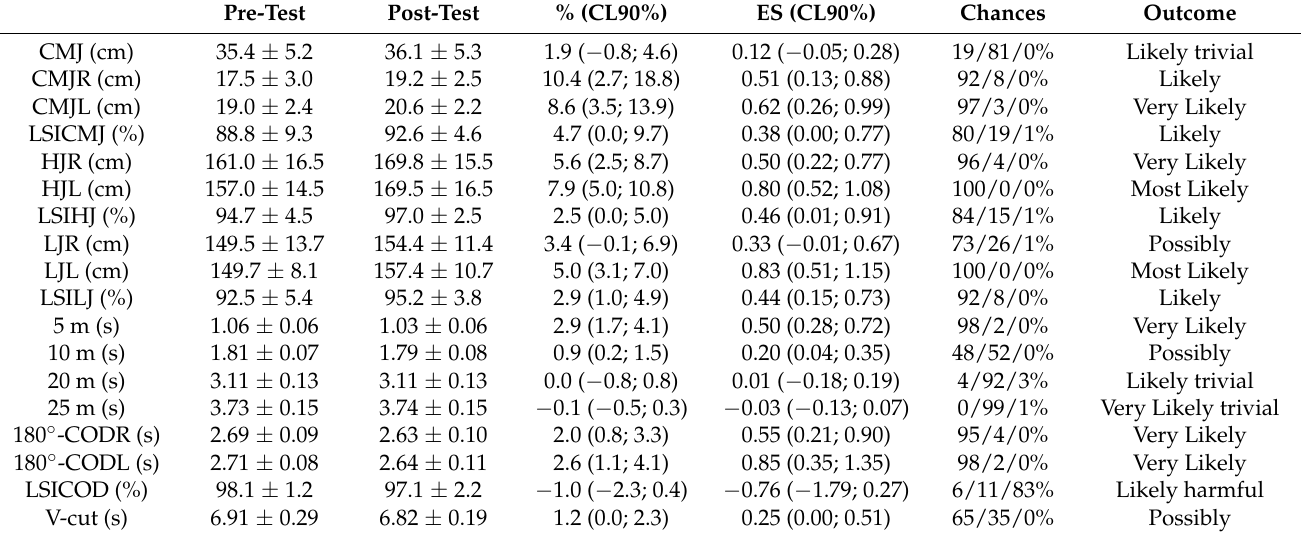
Table 2. Changes in performance after variable unilateral horizontal (VUH, n = 11) eccentric overload training.